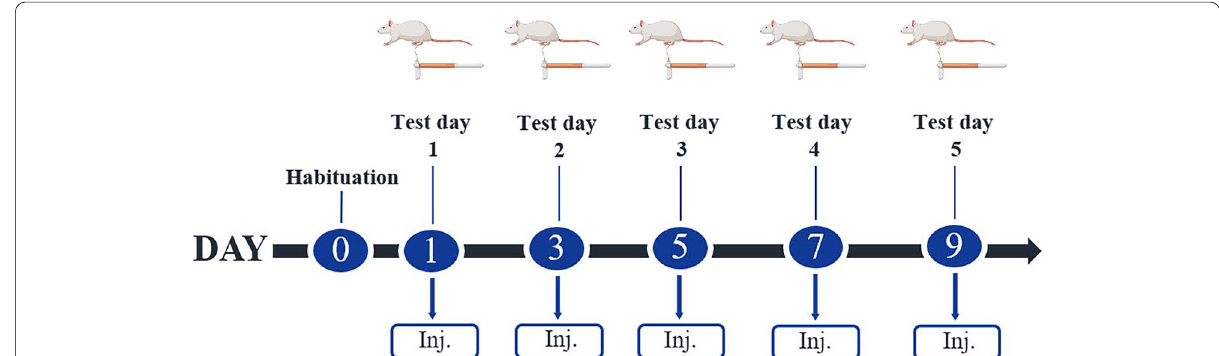
Fig. 1 Design and experimental timeline of test paradigm for the injected trigger compounds. Following 1 day of habituation (day 0), five tests were done every other day over the course of 9 days. All compounds were injected intraperitoneally (i.p.) except for PACAP38 that was given subcutaneously (s.c.). Anti‑PACAP antibodies (30 mg/kg) or IgG control (30 mg/kg) were injected once (day 0) 24 h prior to test day 1. Pre‑treatment of sumatriptan (0.6 mg/kg) was given on every test day 20 min prior to the injection of PACAP38. On every test day, the basal threshold of cutaneous sensitivity was measured using Von Frey filaments prior to injections and the acute response after injections was measured after 1 h for PACAP38 and 2 h for GTN and